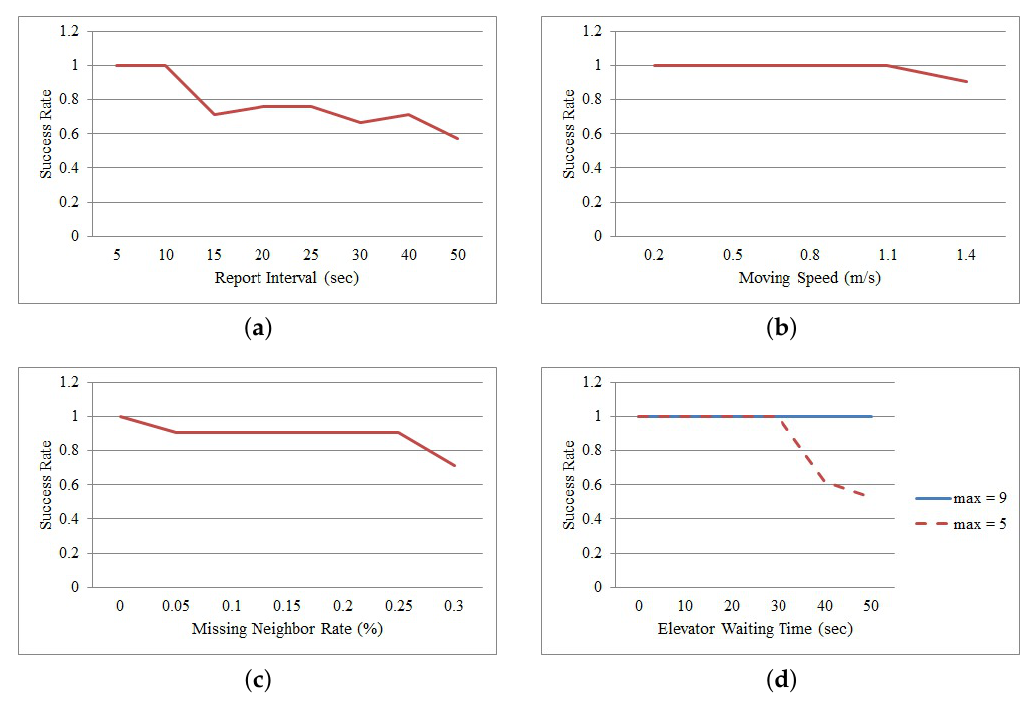
Figure 5. Detection results of both failed and left nodes in a grid model according to the parameter changes. ( a ) Report interval; ( b ) Moving speed; ( c ) Missing neighbor rate; ( d ) Elevator waiting time.